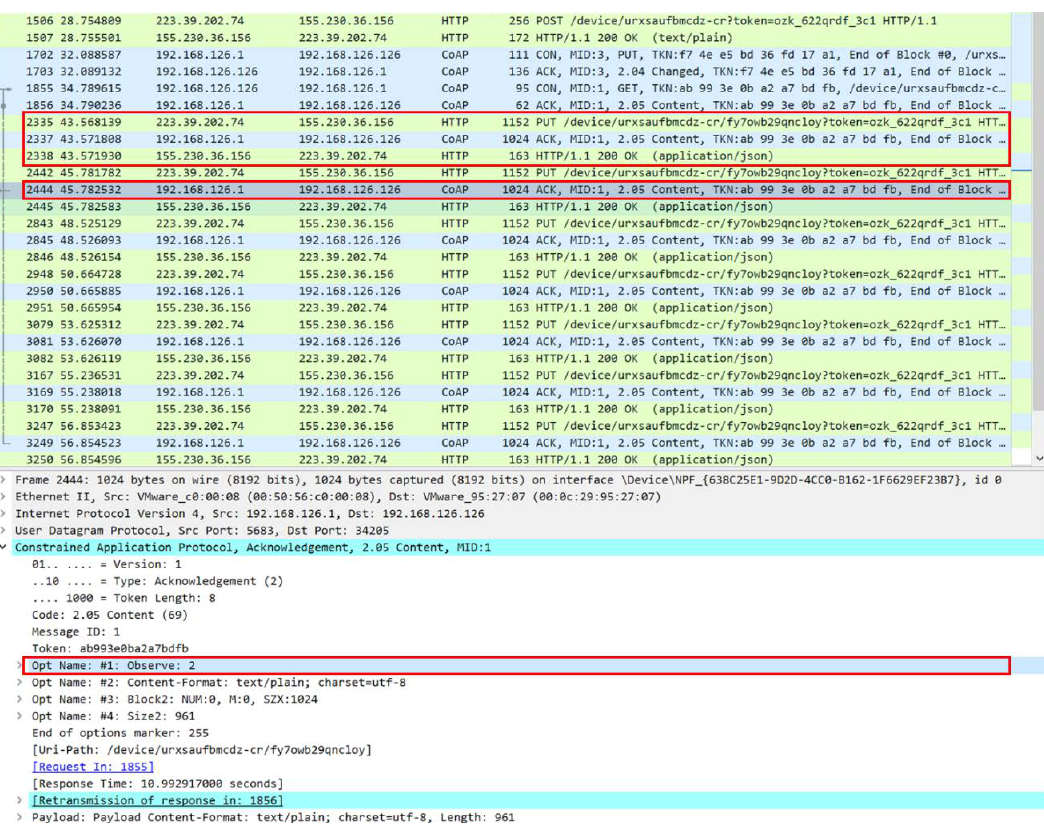
Figure 22. Packet capturing results for direct communication.